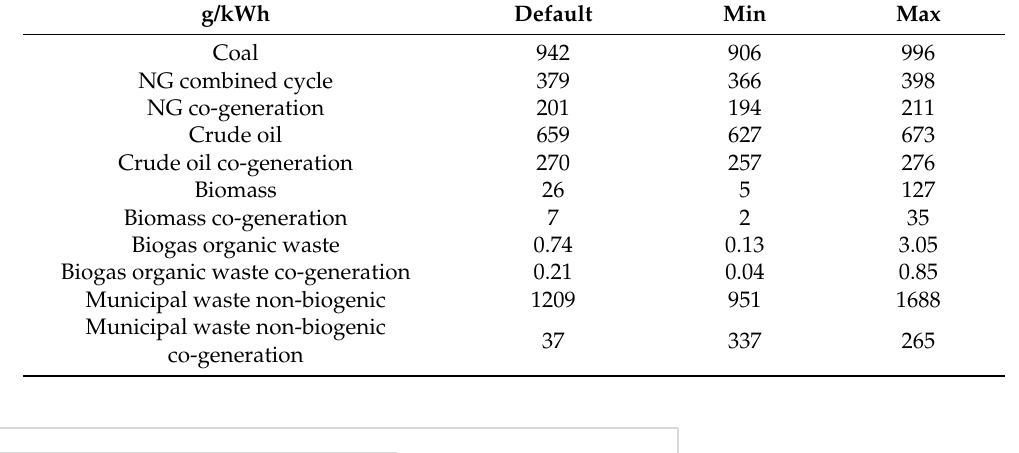
0%10%20%30%40%50%60%70%80%90%100%